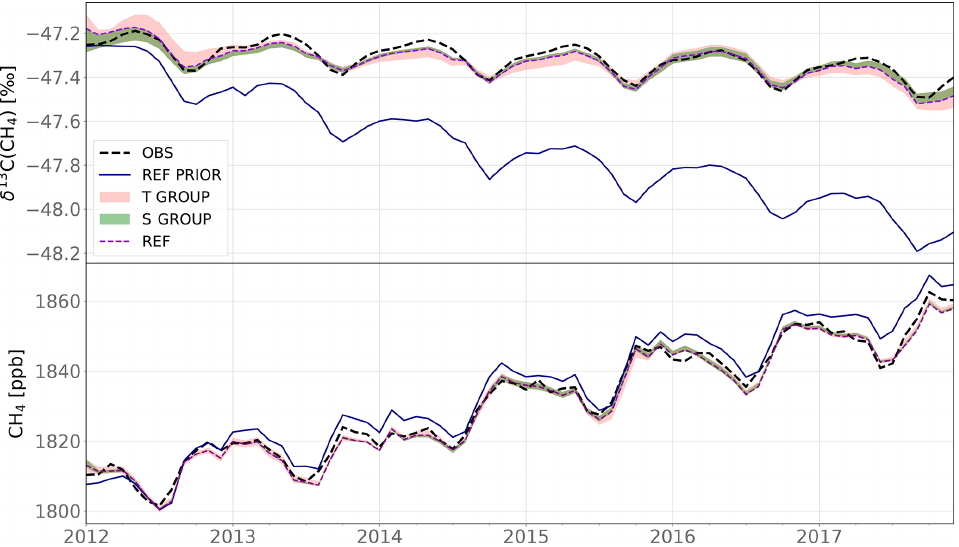
Figure 4. Global monthly δ 13 C ( CH 4 ) and CH 4 means between 2012 and 2017. The dashed black and solid blue lines in each panel denote the observed and prior simulated values (REF), respectively. The red and green ranges show the maximum and minimum values of the T group and S group, respectively. The thick and dashed purple line denotes the posterior REF values. Globally averaged values are computed using a method similar to Masarie and Tans (1995), where a function including three polynomial parameters (quadratic) and eight harmonic parameters is fitted to each time series at available sites. The final value is obtained by performing a latitude-band weighted average over the marine boundary layer (MBL) sites. The latitude band width was set at 30 ◦ . The posterior NOISO lines were not included because (1) the posterior NOISO global source signature is − 54.1‰, and the line would therefore reach lower values than the REF PRIOR, affecting the visual clarity of the upper plot. (2) The posterior NOISO CH 4 values are extremely close to the REF values, and including it would also affect the clarity of the lower